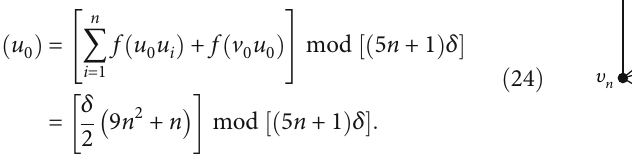
n Þ with ordinary